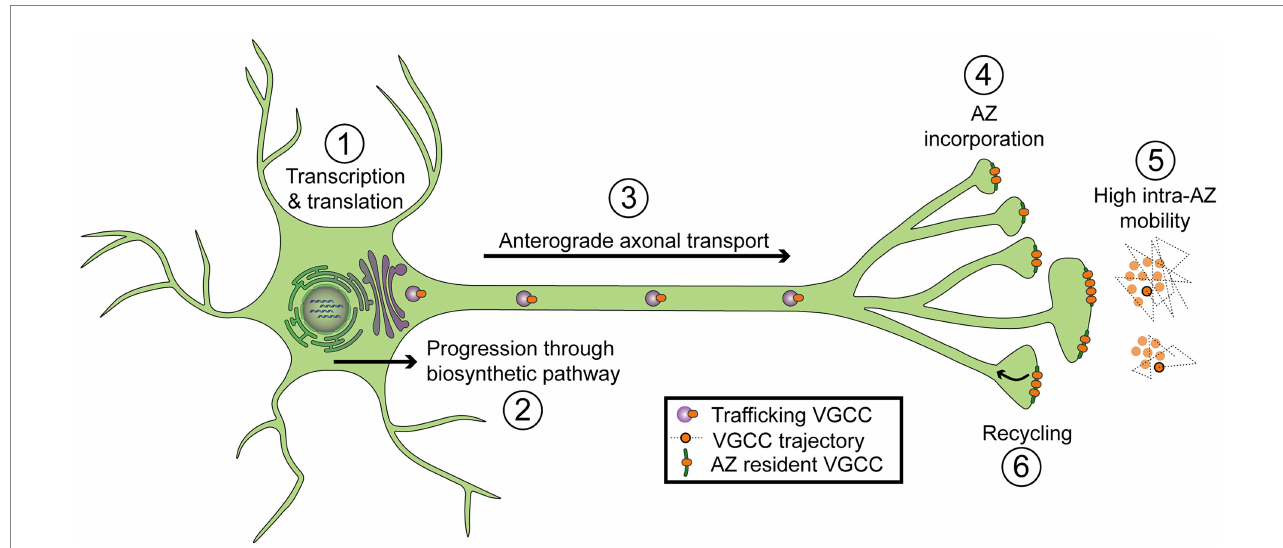
FIGURE 4 Diagram of regulatory steps involved in setting VGCC abundance at synaptic AZs. (1) Transcription and translation. (2) Progression through the biosynthetic pathway, including the endoplasmic reticulum and Golgi. (3) Forward axonal trafficking. (4) Incorporation into AZs through local interactions with scaffolding proteins. (5) High mobility within individual AZs (intra-AZ mobility) and low inter-AZ mobility. Cartoon on the right depicts a top-down view of VGCCs residing in two nearby AZs. Dotted lines represent short-term trajectories of VGCCs outlined in black. (6) Recycling of